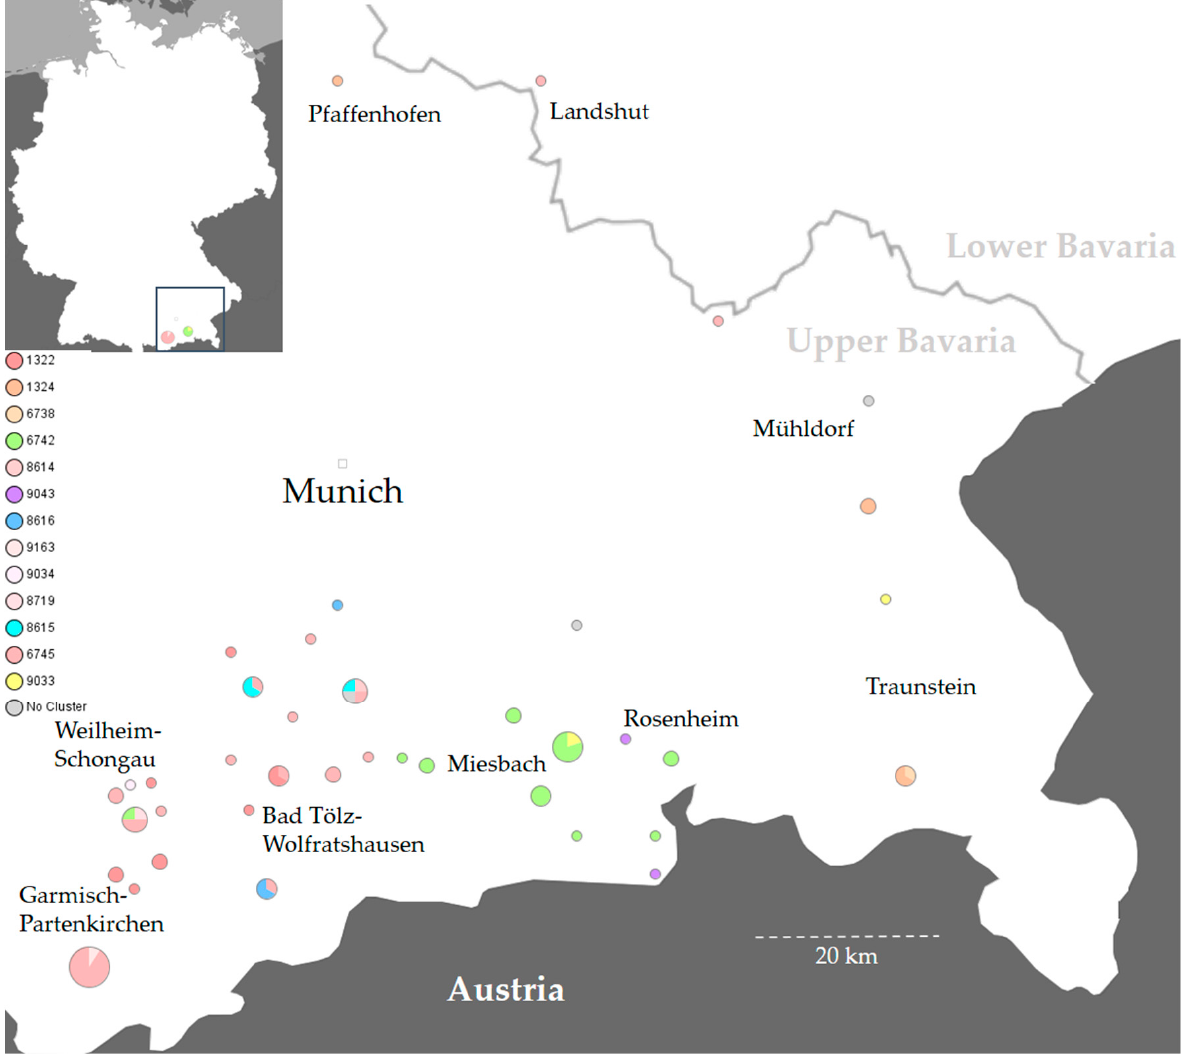
Figure 2. A map of Germany (top left) and the respective enlarged map extract depict the two administrative regions of Upper and Lower Bavaria, the state capital Munich, and various districts in Southern Bavaria affected by Salmonella Dublin in the 2017–2021 period. The individual clusters and cgMLST complex types (CTs) are highlighted in different colors. A CT legend is reflected on the left side of the map. The circle size represents the number of identified isolates. Cluster 1 (red shades) is dispersed throughout Southern Bavaria, whereas other clusters have a local focus. Isolates that could not be assigned to any cluster are marked in gray. The map was created with SeqSphere+ and Microsoft PowerPoint.